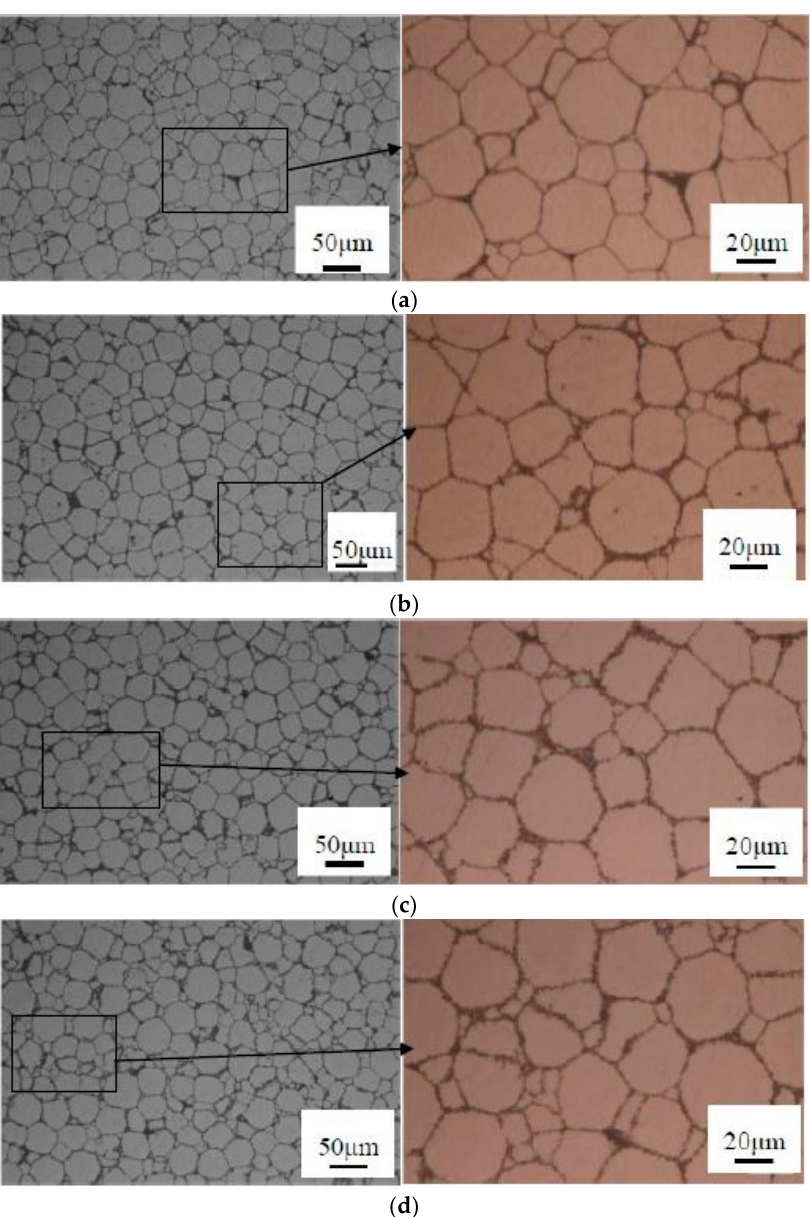
Figure 8. OM micrograph of AA6061/5 vol.% N-SiC composites sintered at 450 ( a ), 550 ( b ), 600 ( c ), 650 ( d ) °C.